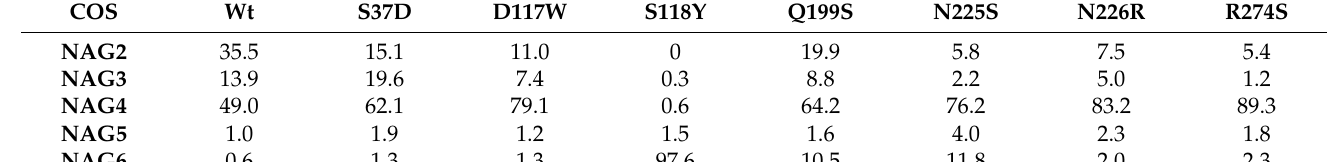
Table 2. Relative abundance of COS (%) in the referred Chit33 variants after 4 h reactions.